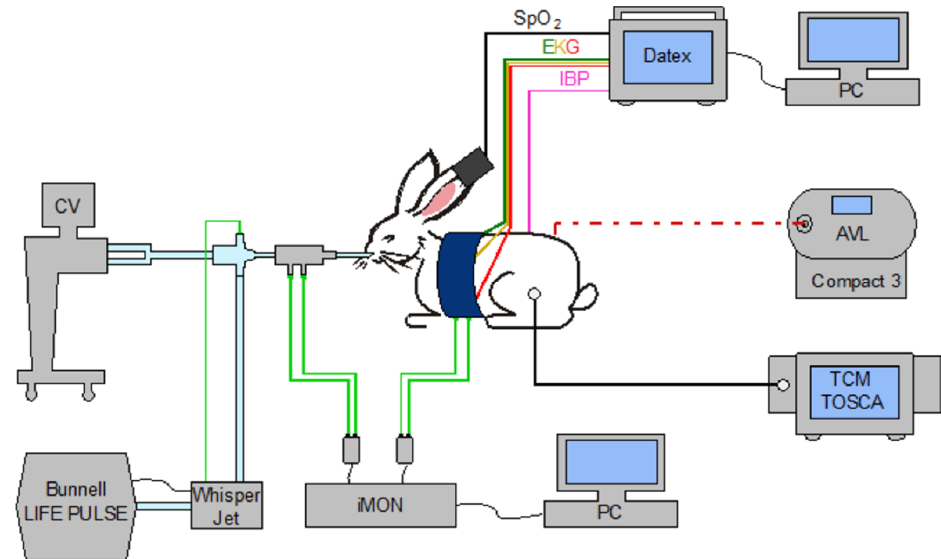
Figure 7. Arrangement of an animal experiment. The animal model is intubated and connected to a neonatological jet and a conventional ventilator. Sensing of the pressure difference arising on the flow sensor and the cuff pressure (monitoring chest excursions) is measured synchronously using iMON and stored in a PC. The DATEX monitor monitors life functions; data are stored on a PC. A transcutaneous blood gas monitor continuously monitored the development of tcpO 2 and tcpCO 2 ; blood gas analysis was provided by an external analyzer AVL Compact3.